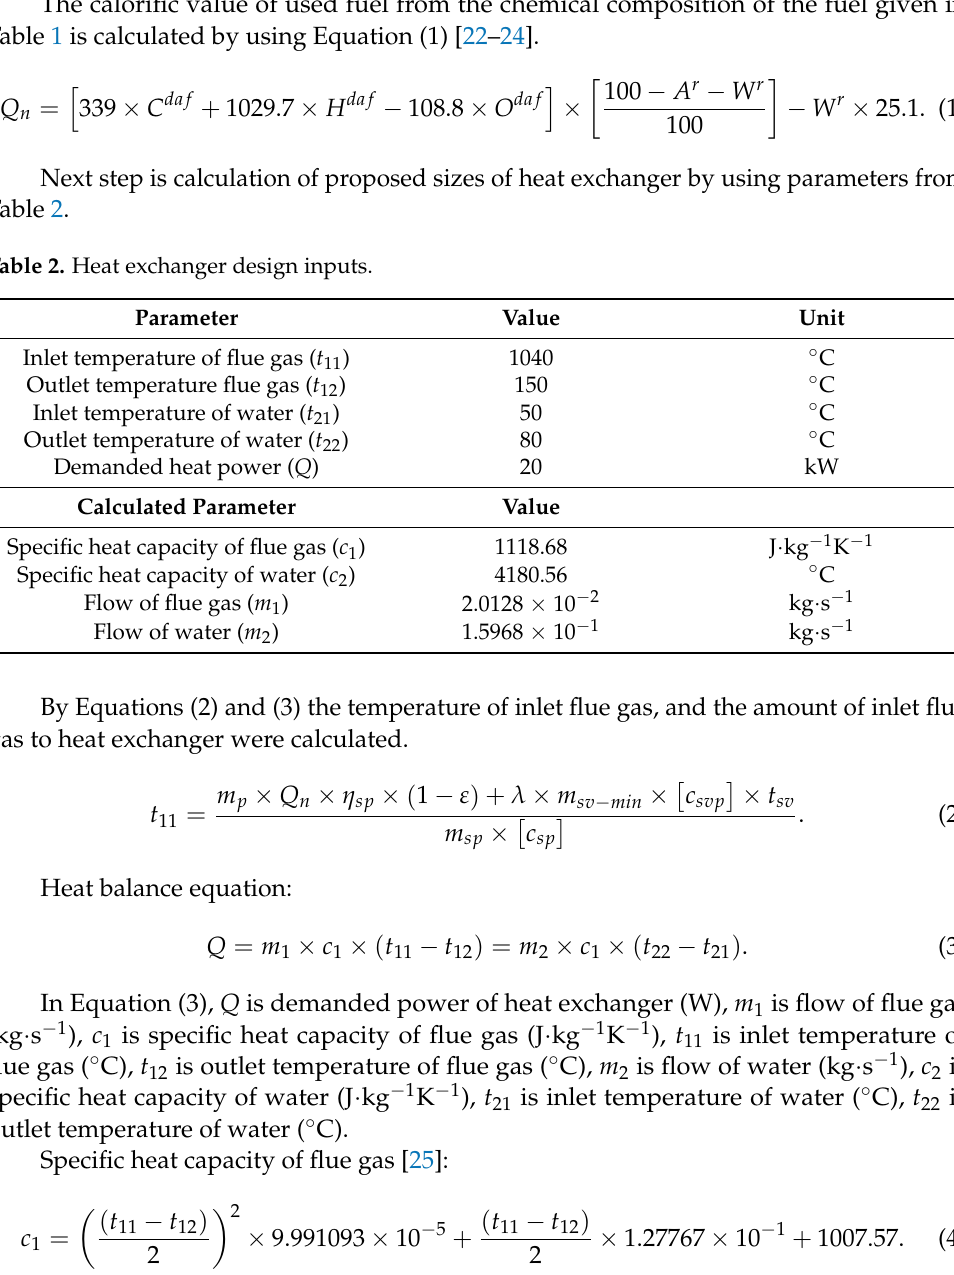
Table 1. Chemical composition of combusted fuel (wheat straw) [21]. Chemical Composition of Fuel C daf 46.05% H daf 5.93% O daf 42.95% N daf 0.58% A r 4.31% W r 7.7%